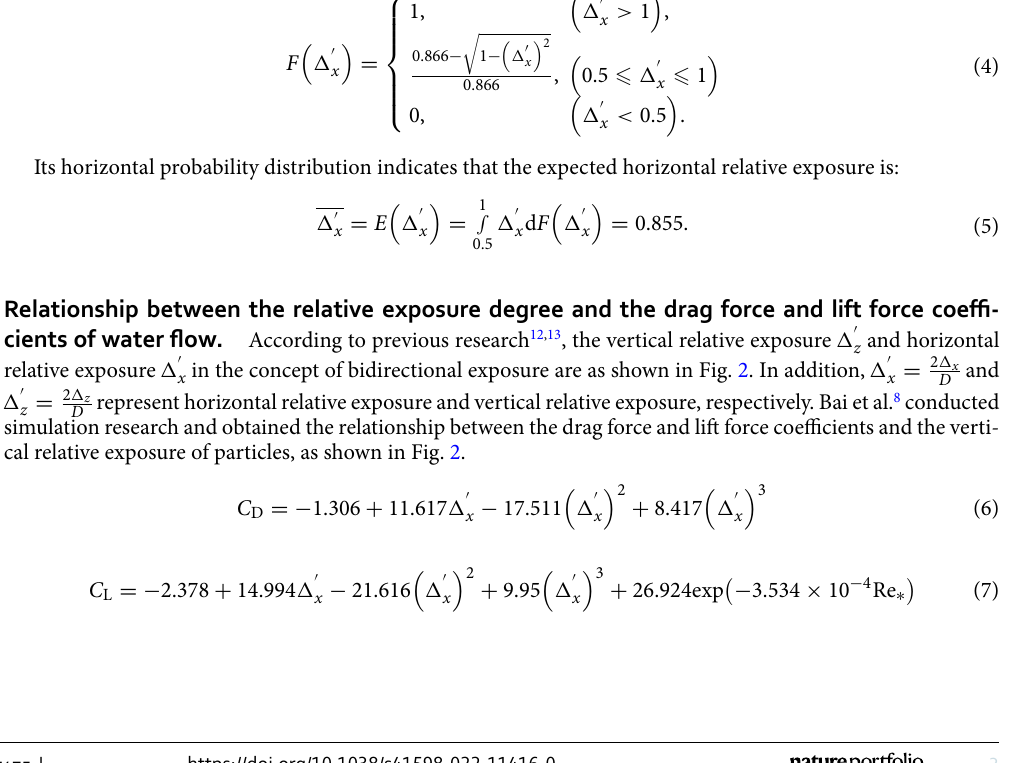
Due to the similar sizes of clay and sand particles in sandy silt, (cid:31) ′ x should fall in the range of 0.5 D / D l (cid:31) � ′ (cid:31) D / D l . Thus, the probability distribution function of (cid:31) ′ lx